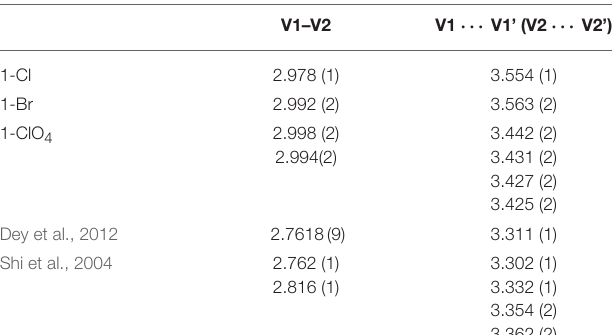
TABLE 2 | Distances (Å) between vanadium centers. The serial numbers of vanadium centers are shown in Figure 1